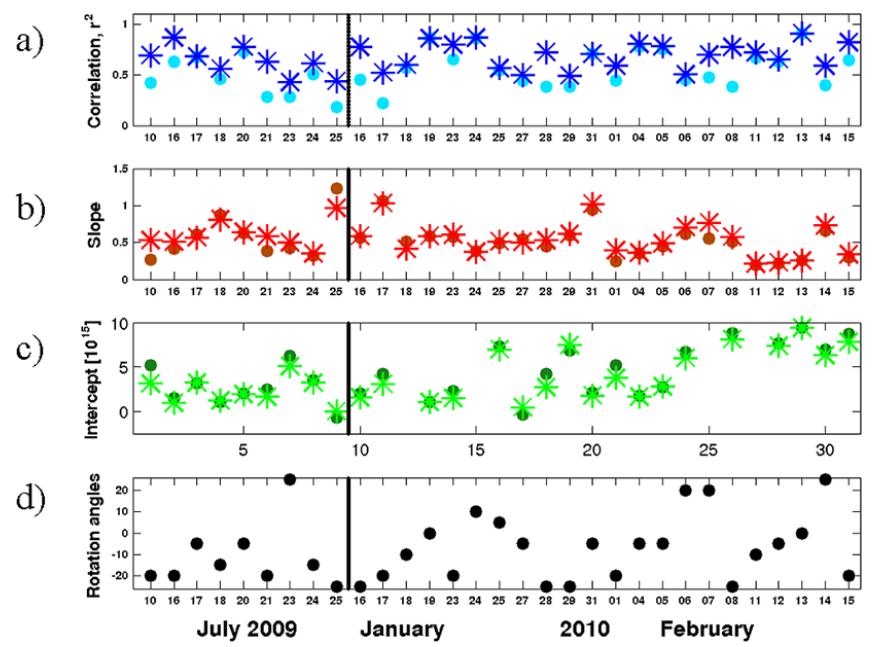
Figure 6. Results of the spatial correlation analyses between CHIMERE and car-MAX-DOAS for individual days (dots: results for original CHIMERE data; stars: results for rotated CHIMERE data). (a) Correlation coefficients; (b) slopes of the regression lines; (c) y axis intercepts; (d) optimum rotation